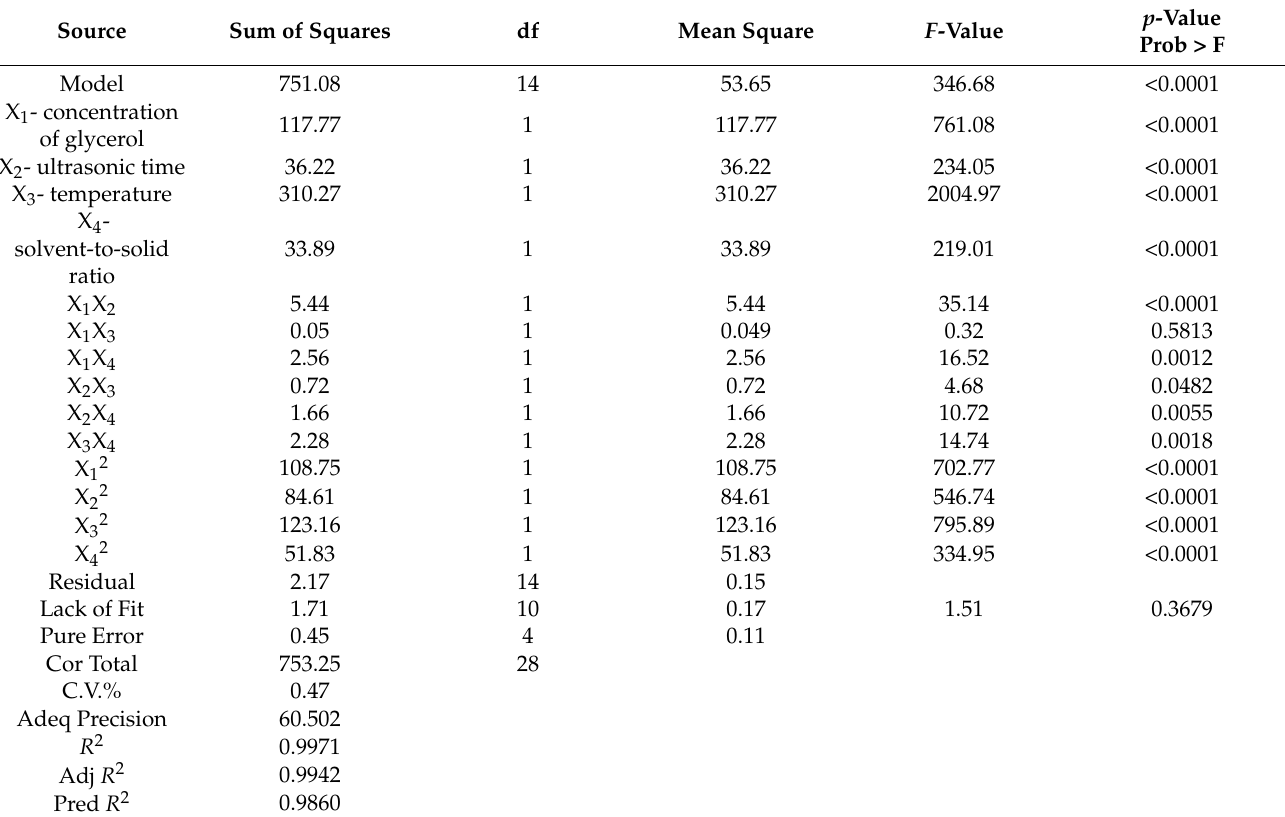
Table 3. Analysis of variance for response surface quadratic